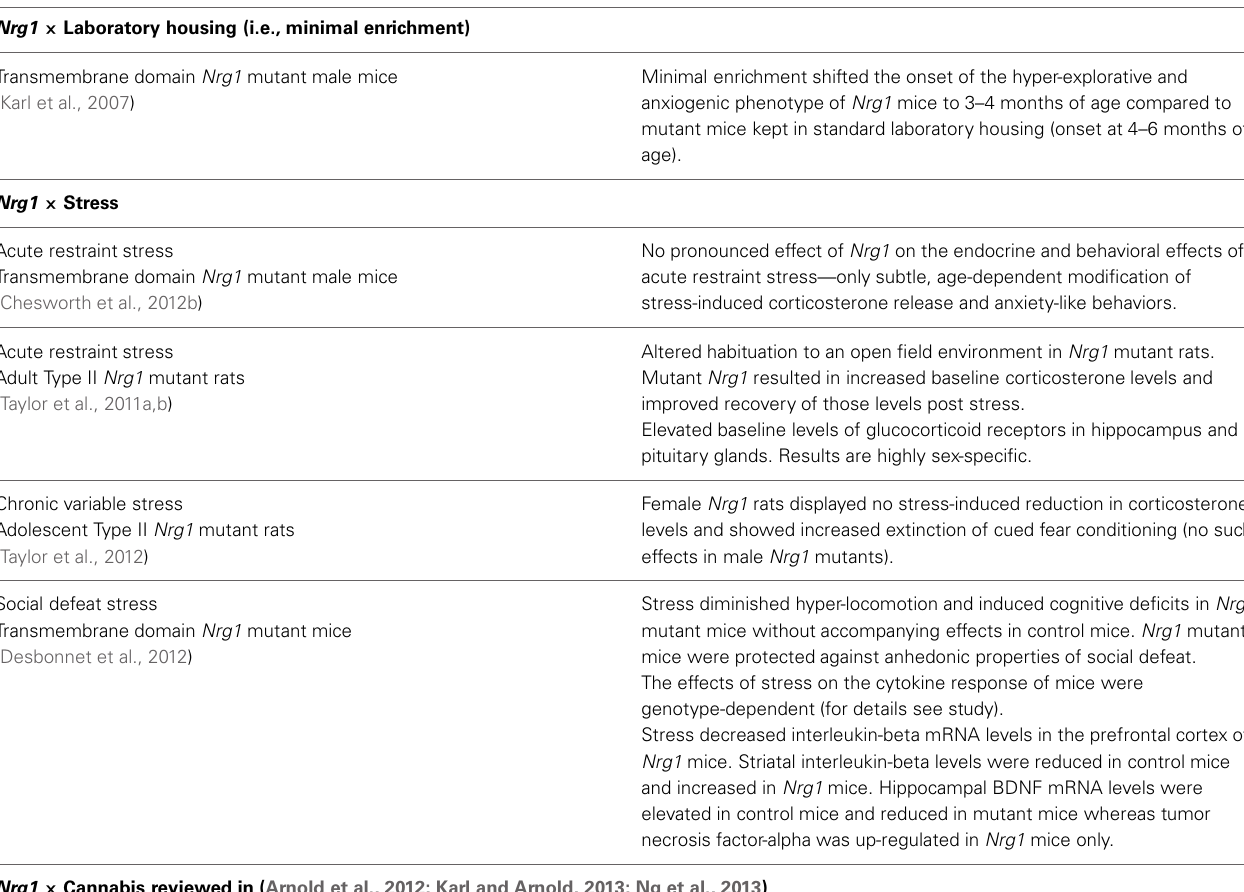
Table 1 | Effects of environmental factors on rodent models for the schizophrenia candidate gene neuregulin 1. Nrg1 × Laboratory housing (i.e., minimal